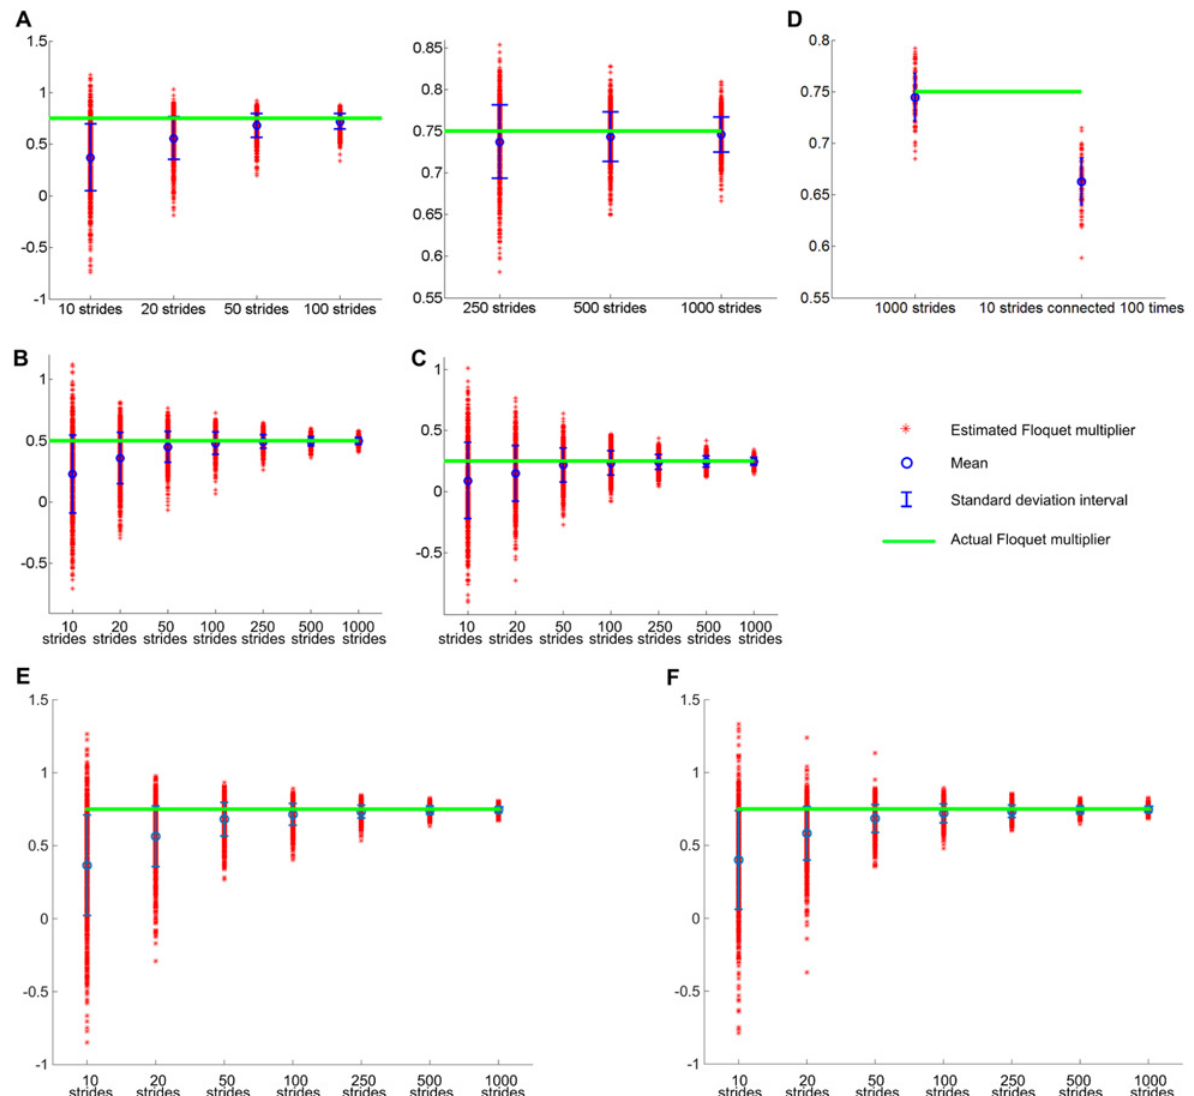
Fig 1. Estimation of a Floquet multiplier (FM) using linear regression. Time series with different length, n were generated using Equation (1). Noise from a normal distribution was added to each cycle and values of FM were 0.75 (A), 0.5 (B) and 0.25 (C). The FM was evaluated for each time series using linear regression. The simulation was repeated 1000 times for each n . Red asterisks show the 1000 estimates of FM, blue circles denote their mean and the whiskers denote their standard deviation. For any value of actual FM, the mean of the estimated FMs is always smaller, though the discrepancy decreases as — the null hypothesis that the estimated orbital n increases. For clarity, case A is presented in two panels, the second with an expanded vertical scale. H 0 stability comes from a normal distribution with mean equal to the actual value — is rejected even when n = 1000. In D, the estimation of FM = 0.75 from a time series with n = 1000 was compared with estimation from a stitched time series that consisted of 100 time series with n = 10. Though the length of the two cases are the same (1000), the stitched time series has significantly larger bias than a single time series. All of these results remain similar when the noise comes from a uniform or lognormal distribution; the estimation of FM using linear regression shows similar bias in the presence of noise from a uniform distribution (E), or an asymmetric lognormal distribution (F).